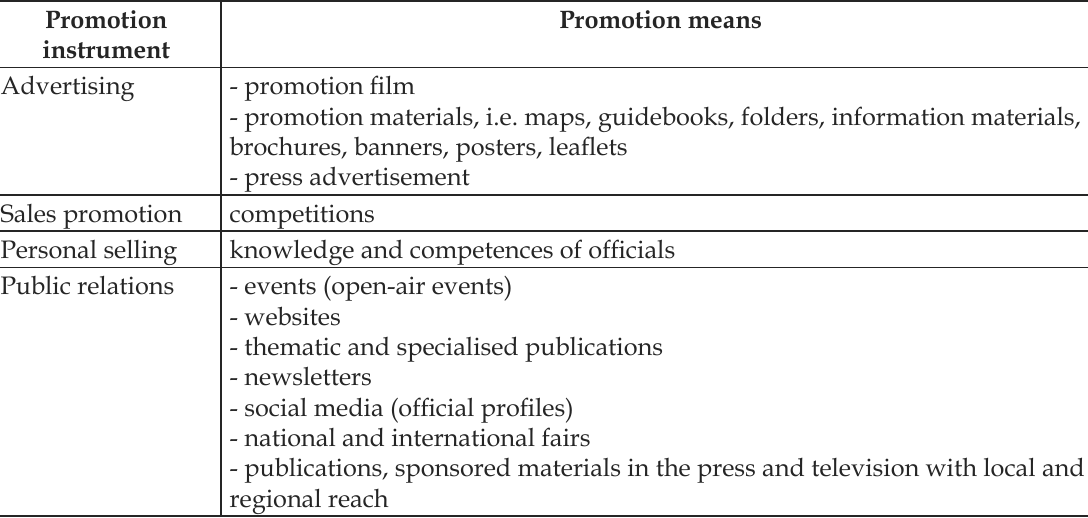
Tab. 5. The Milicz carp in the promotion action of ‘the Barycz Valley’.